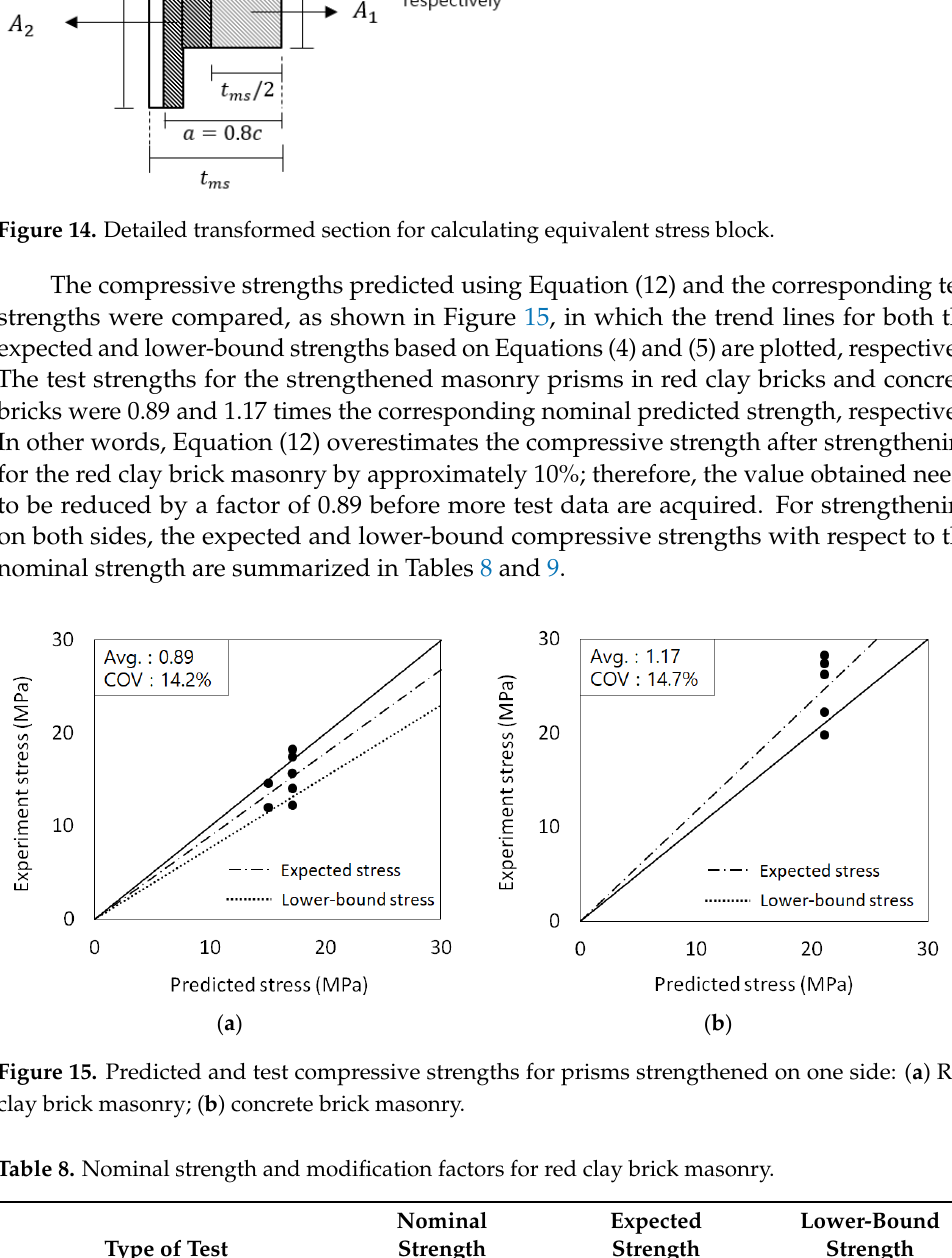
Figure 14. Detailed transformed section for calculating equivalent stress block.